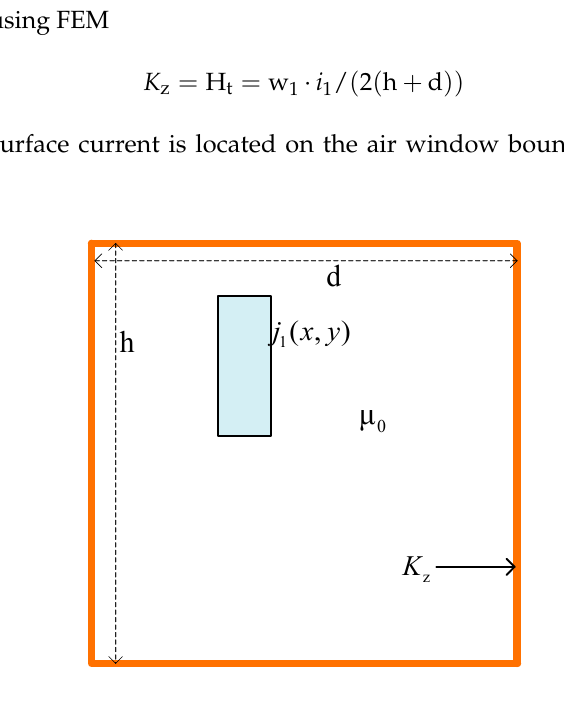
in considered case.